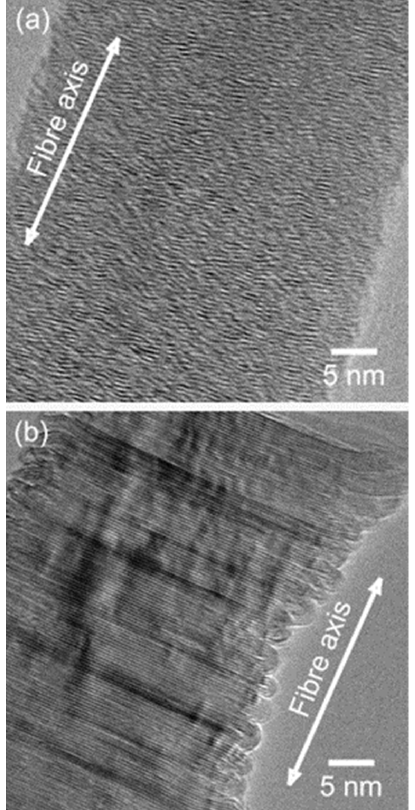
Figure 26. TEM images of the nanofilaments heated at: ( a ) 1000 °C and ( b ) 2800 °C. From the work carried out by Habazaki et al. [227]. Reprinted with permission from Ref. [227]. Copyright © 2023 Elsevier Ltd. All rights reserved.